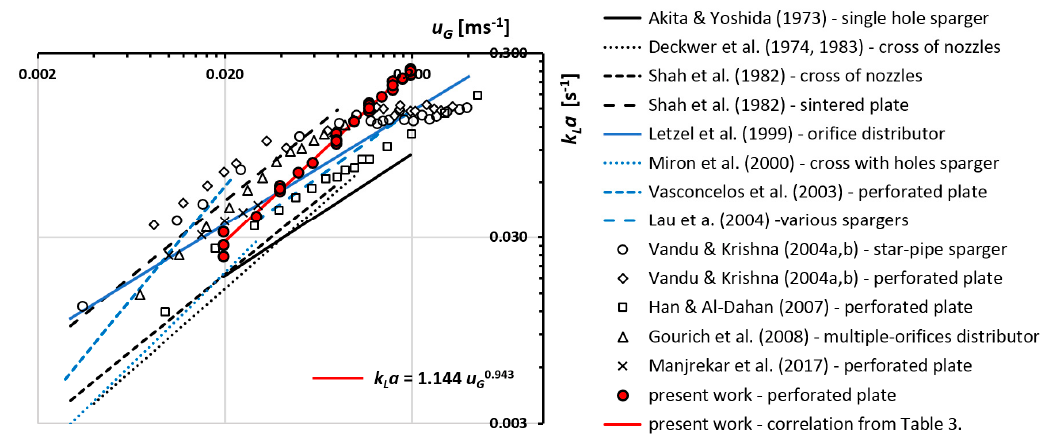
Figure 7. Dependence of volumetric mass transfer coefficient on gas superficial velocity, comparison of present data with correlations and data provided in Table 1.